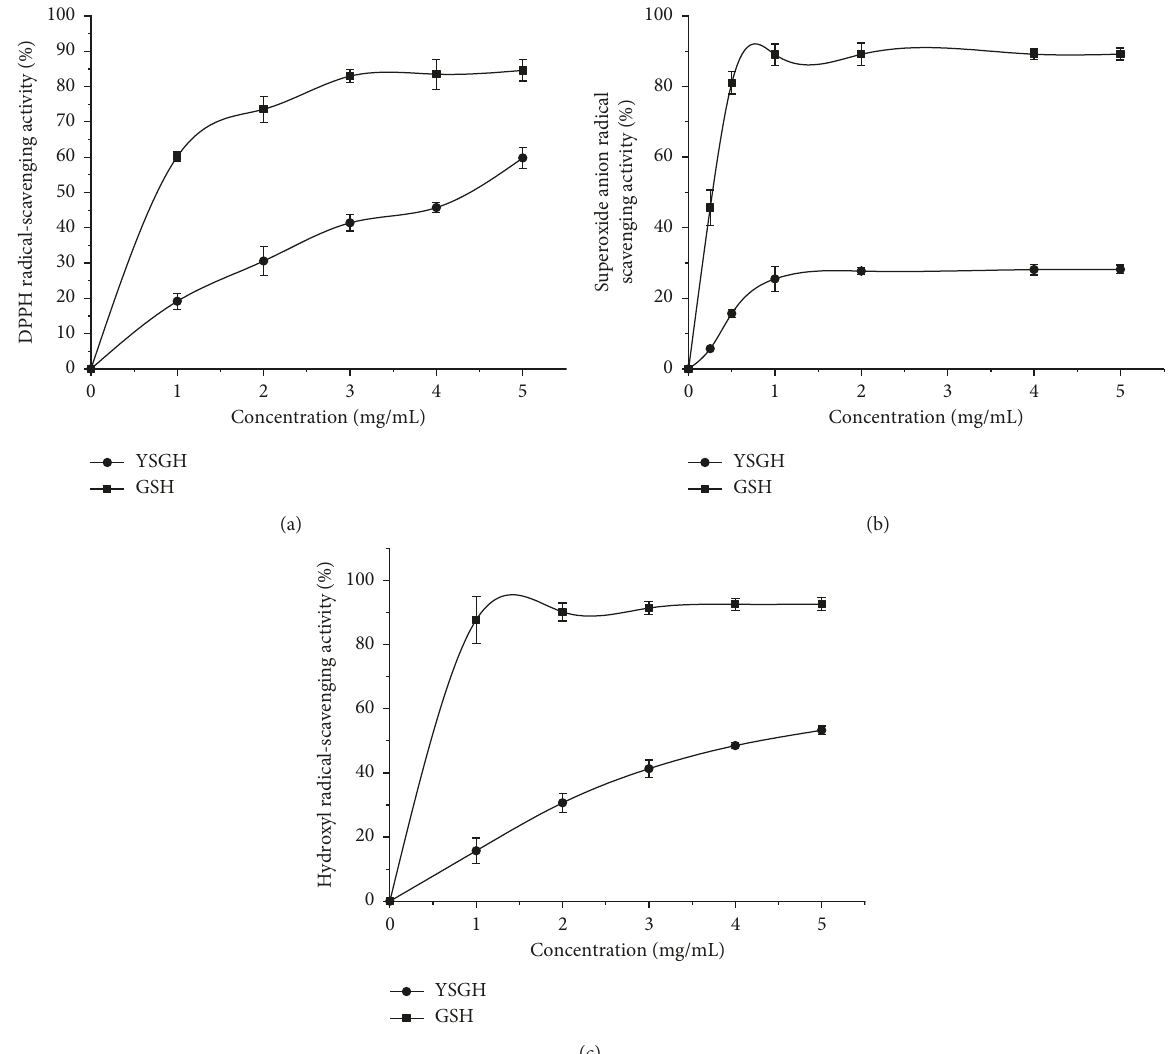
L -glutathione (GSH). (a) Effect on DPPH free radicals;